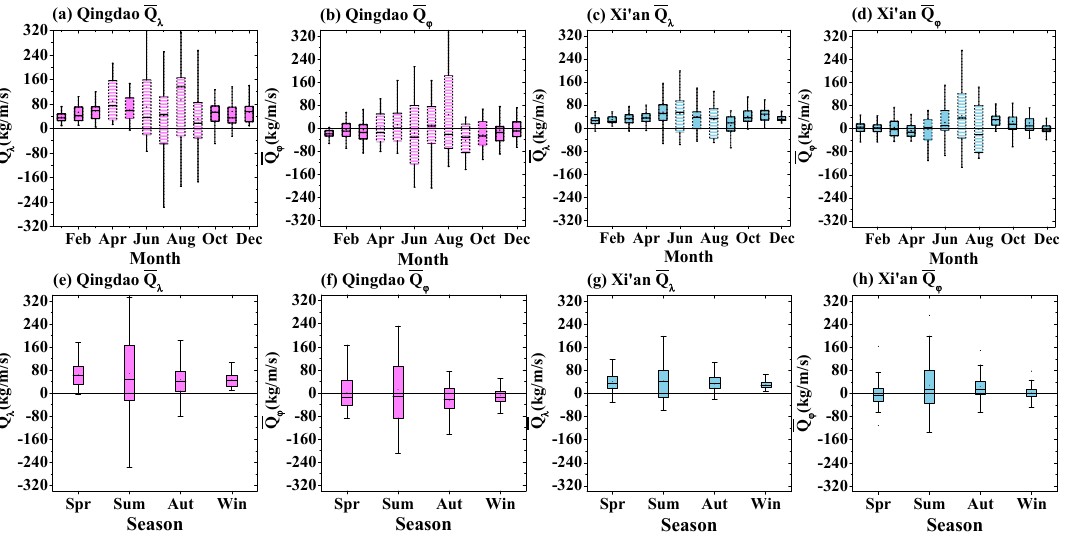
Figure 10. Monthly variations of the WVFs in Qingdao and Xi’an: the zonal vertically integrated WVFs in ( a ) Qingdao and ( c ) Xi’an; the meridional vertically integrated WVFs in ( b ) Qingdao and ( d ) Xi’an; seasonal variations of the WVFs in Qingdao and Xi’an: the zonal vertically integrated WVFs in ( e ) Qingdao and ( g ) Xi’an; the meridional vertically integrated WVFs in ( f ) Qingdao and ( h ) Xi’an.